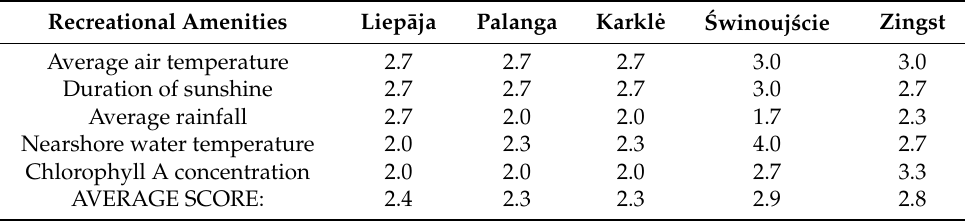
Table 2. Average scores of the quality of recreational amenities in the studied South Baltic seaside resorts (scores from 1—poor to 5—excellent).